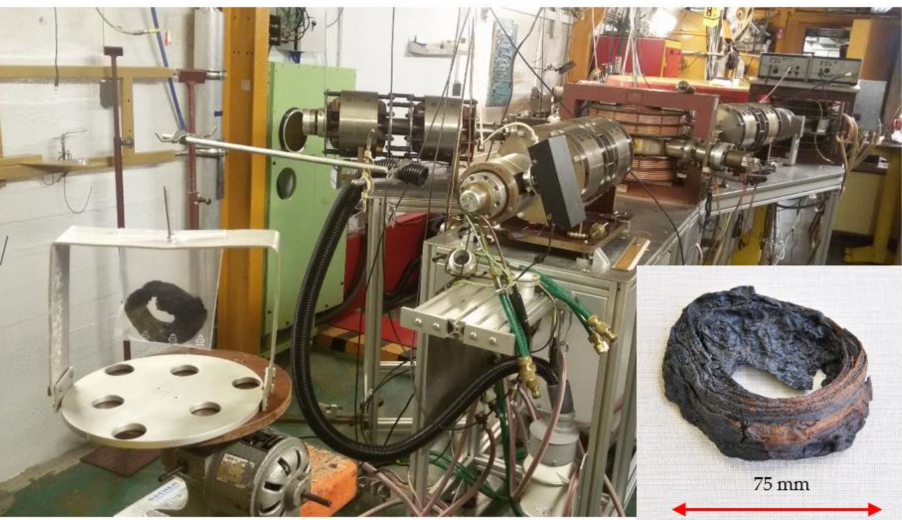
Figure 1. Experimental set-up for Bremsstrahlung irradiation of the whole rotated bracelet (insert in lower right corner) in a microtron MT25 (according to